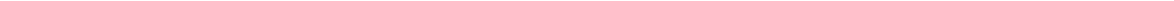
Fig. 5 Isobaric tags for relative and absolute quantitation proteomics study for exploring the anti-cancer mechanism of PMT system. a Heat map showing signi fi cantly upregulated and downregulated proteins (fold change ≥ 1.5 and P < 0.05). b Biological functions, cellular component, and molecular functions of differential proteins based on GO annotation. c Venn diagram indicated the non-overlapped biological effect of E. coli and NO generated from PMT system. Histograms of differential proteins associated with E. coli infection, bacteria invasion, DNA damage, and oxidative stress based on GO annotation. d Functional interaction network of PMT regulated proteins was analyzed by using Search Tool for the Retrieval of Interacting Genes/Proteins (STRING) algorithm. e KEGG pathway analysis for antigen processing and presentation associated differential proteins (upregulation proteins were marked with a red box). f Flow cytometry for evaluating the DC maturation. g – i Dead-cell proximity index and Euclidean distance matrix analysis index of